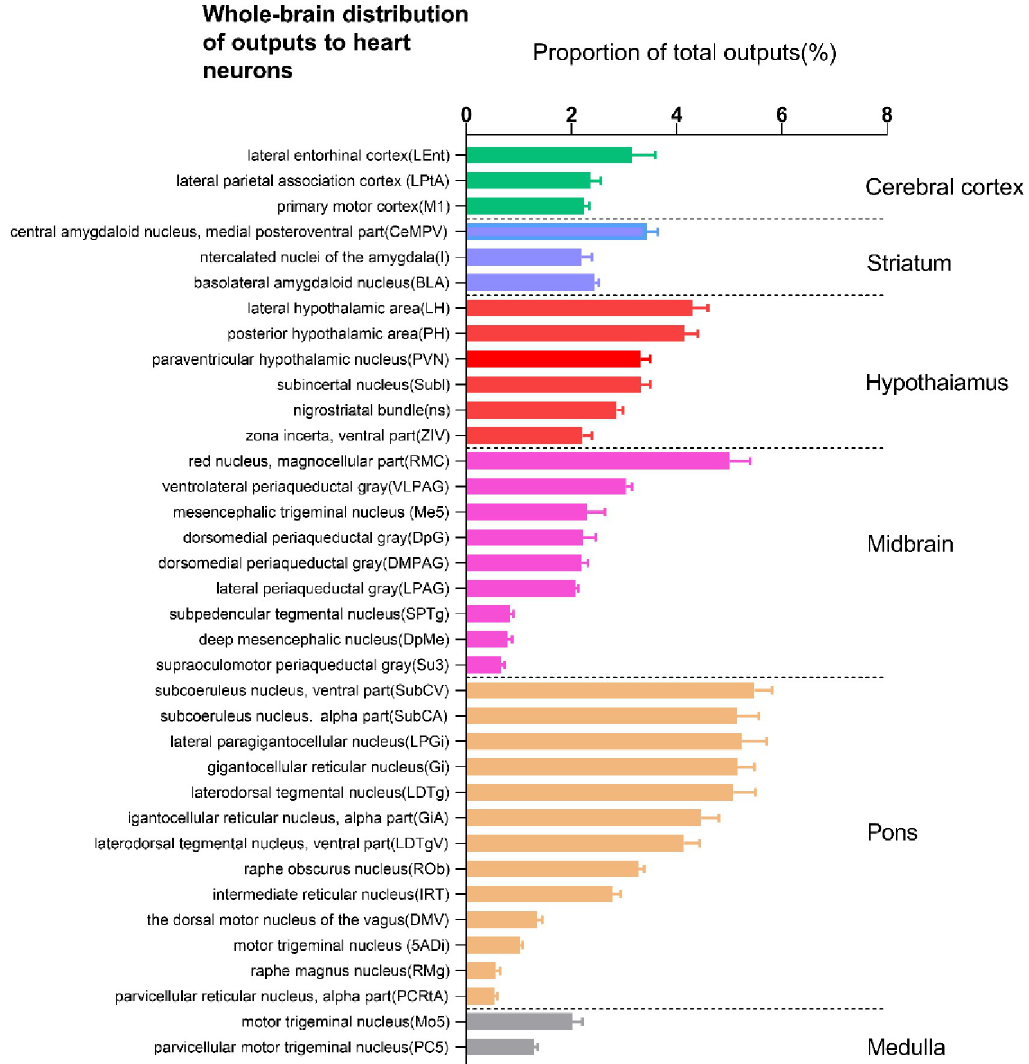
Fig 2. Statistical analysis of the whole-brain distribution of outputs to heart. This data is based on the ratio of the number of EGFP-expressing neurons in each nucleus to the total number of labeled neurons in each brain (n = 4 mice). The percentages reflect the retro-labeled output neurons from 36 regions in C57/BL mice. Brain areas are grouped into six general structures: cerebral cortex, hypothalamus, midbrain, pons, and medulla.